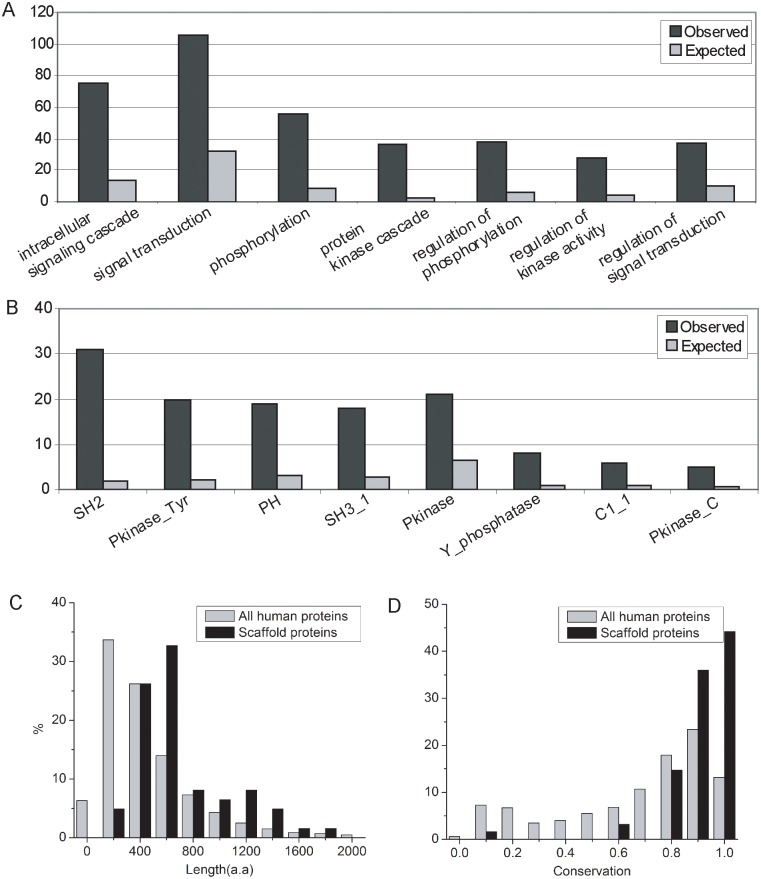
Characterization of scaffold proteins.(A) Enriched GO terms for scaffold proteins. (B) Enriched protein domains defined by Pfam in scaffold proteins. The GO and Pfam terms are sorted increasingly from left to right by p-value. (C) Distribution of protein lengths. (D) Distribution of evolutionary conservation.